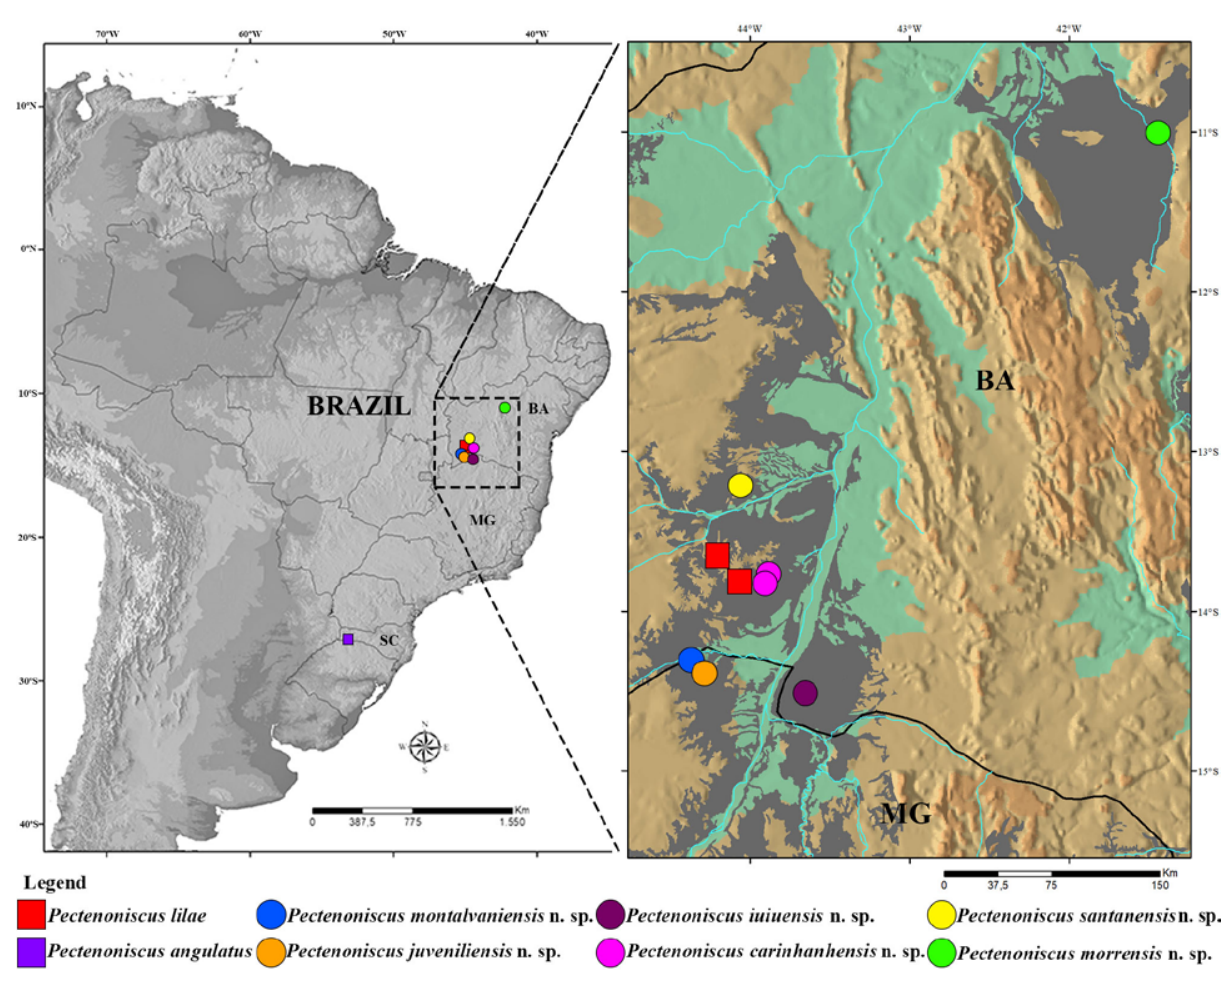
Figure 21. Map of South America highlighting Brazil and the states of Bahia (BA), Minas Gerais (MG), and Santa Catarina (SC), where the species of Pectenoniscus are recorded. Brown and green colors indicate the elevation of the terrain, with brown for higher levels, green for lower levels; gray indicates karstic